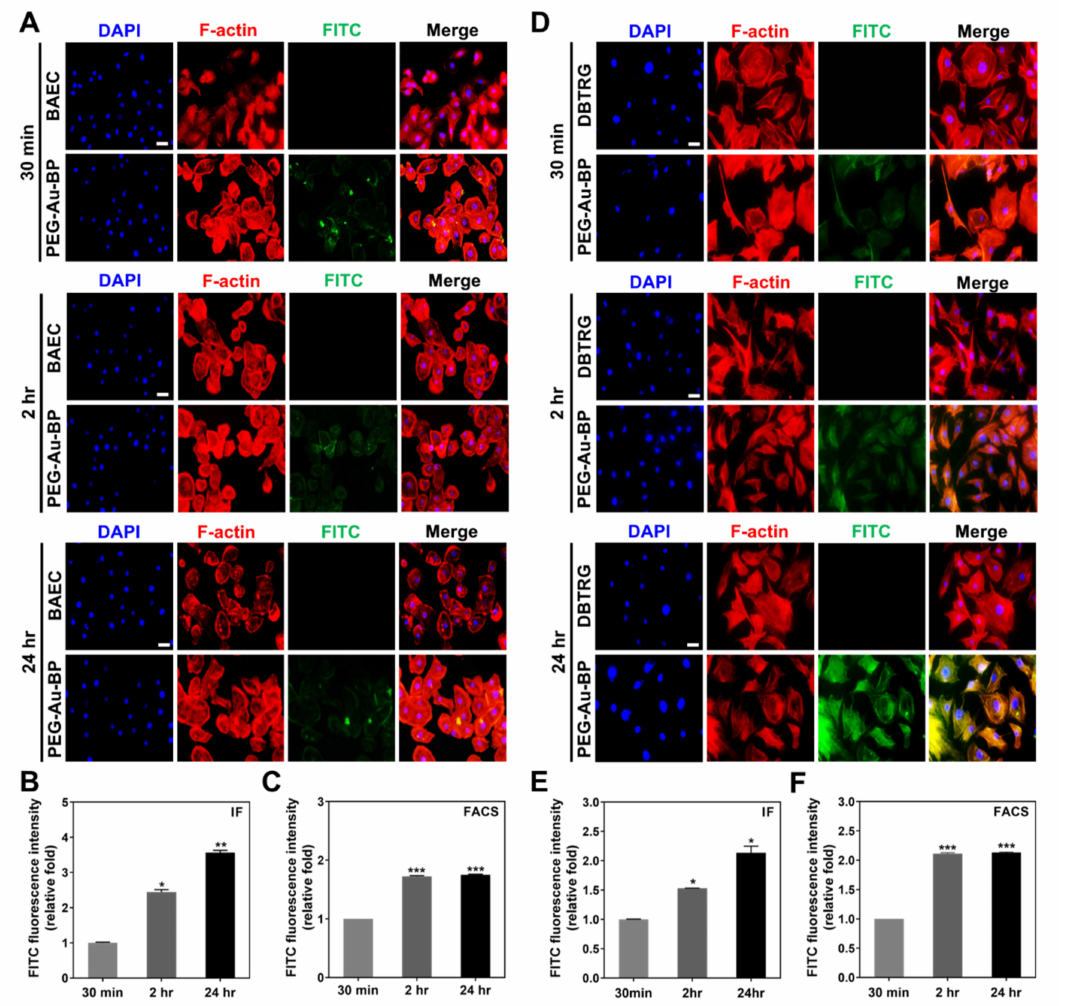
Figure 4. Cell uptake ability in BAEC and DBTRG cell lines treated with PEG-Au-BP. PEG-Au-BP nanoparticles were labeled with fluorescein (FITC) to observe the cell transportation through a fluorescent microscope. The immunofluorescent (IF) images were demonstrated as ( A ) BAEC and ( D ) DBTRG cell lines, including at 30 min, 2 h, and 24 h. Based on the FITC images (green color), the uptake amount at 2 h in both cell lines was discovered to be higher than 30 min, with the 24 h group even higher than the other two groups. Furthermore, the uptake efficiency of both cell lines was semi-quantified by the immunofluorescence (IF) and fluorescence-activated cell sorting (FACS) methods. ( B , C ) The results from both the IF and FACS methods indicate that the uptake amount of PEG-Au-BP in BAEC significantly increased at 2 h and 24 h. ( E , F ) In DBTRG brain cancer cell lines, the semi-quantification results show the remarkably increased amount at 2 h and 24 h in both the IF and FACS methods compared to the 30 min group. Results are demonstrated as one of three independent experiments. DAPI was applied to locate cell nuclei (blue color). Red color fluorescent presented as F-actin. The scale bar equals 20 µ m. * p < 0.05, ** p < 0.01, *** p < 0.001: compared to the 30 min